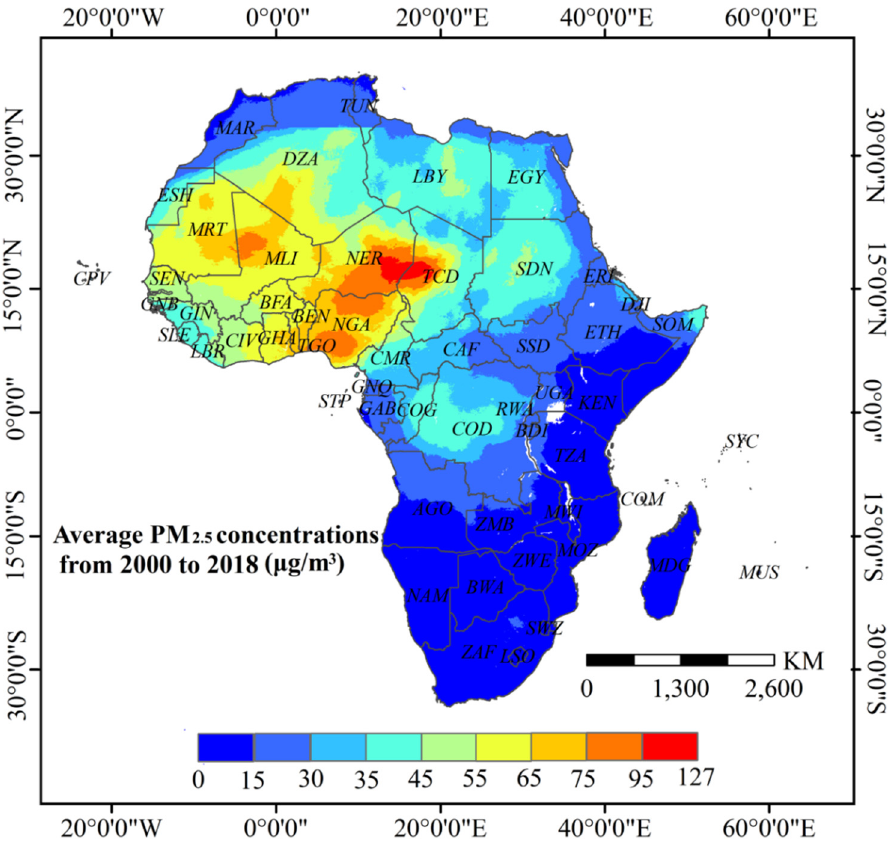
Figure 1. Spatial distribution of average PM 2.5 concentrations in Africa from 2000 to 2018.